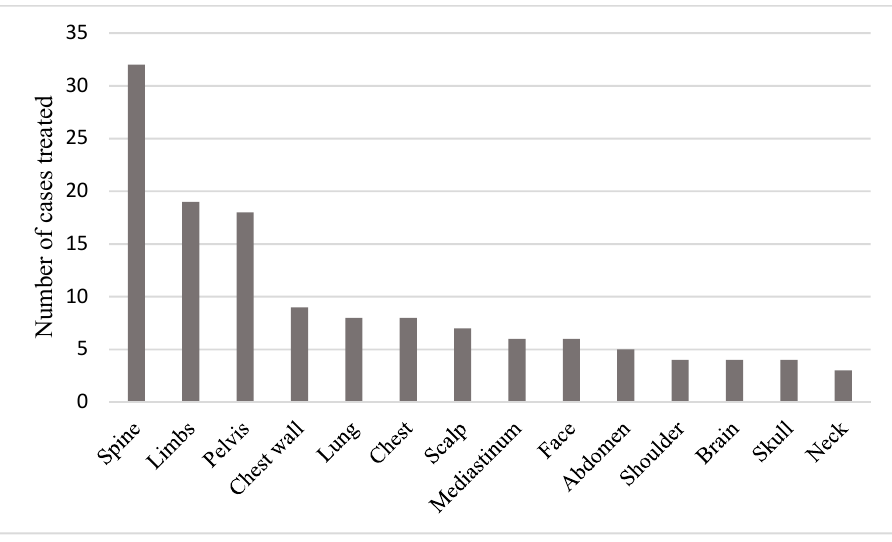
Figure 2. This figure demonstrates the number of cases treated in each anatomical site. Table 2. Dose and fractionation schedules used.